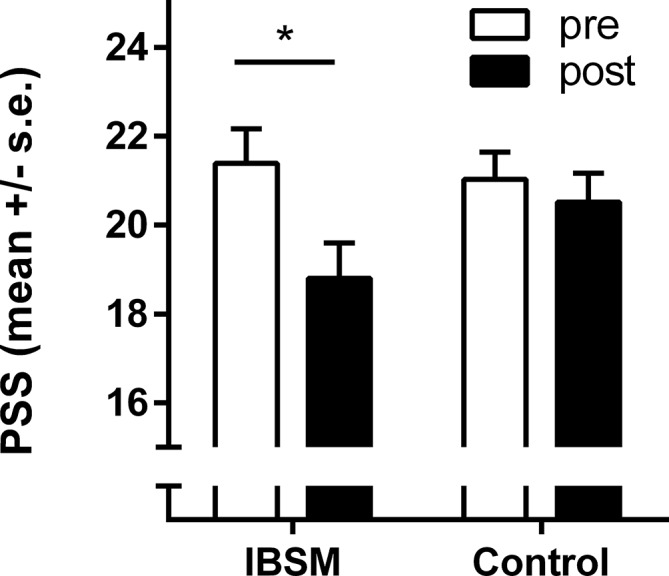
Pre-post differences in the Perceived Stress Scale (PSS) for the Internet-Based Stress Management (IBSM) group and the control group. Bars represent mean ± s.e.; *p < 0.05.